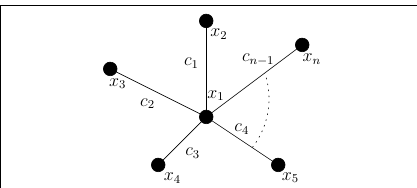
Figure 5: A star on n